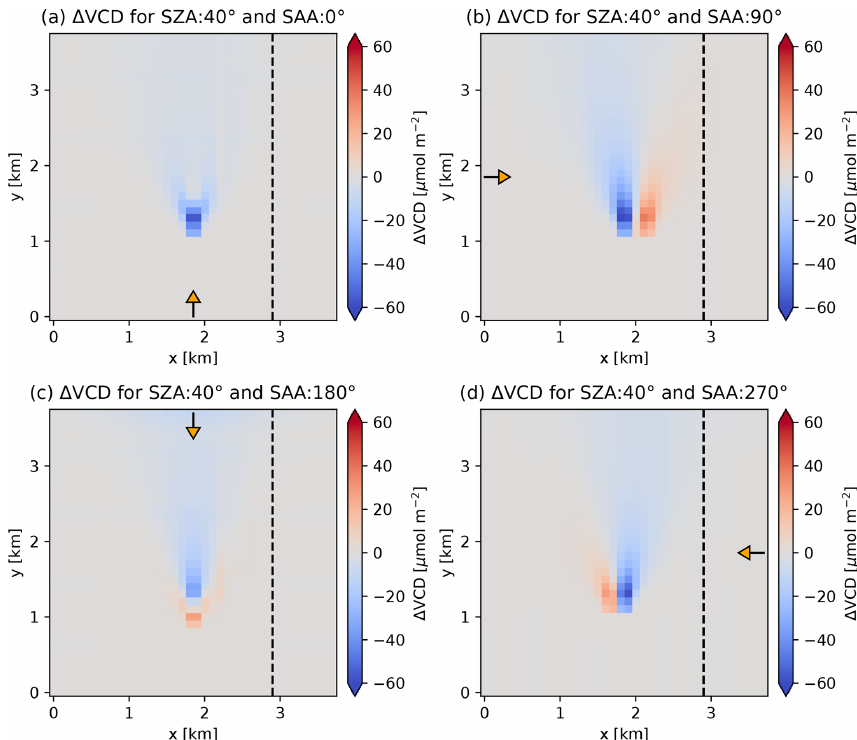
Figure 11. Absolute difference between total VCD from synthetic SCD and 1D box AMF with solar azimuth angle of (a) 0 ◦ , (b) 90 ◦ , (c) 180 ◦ and (d) 270 ◦ and the true total VCD.